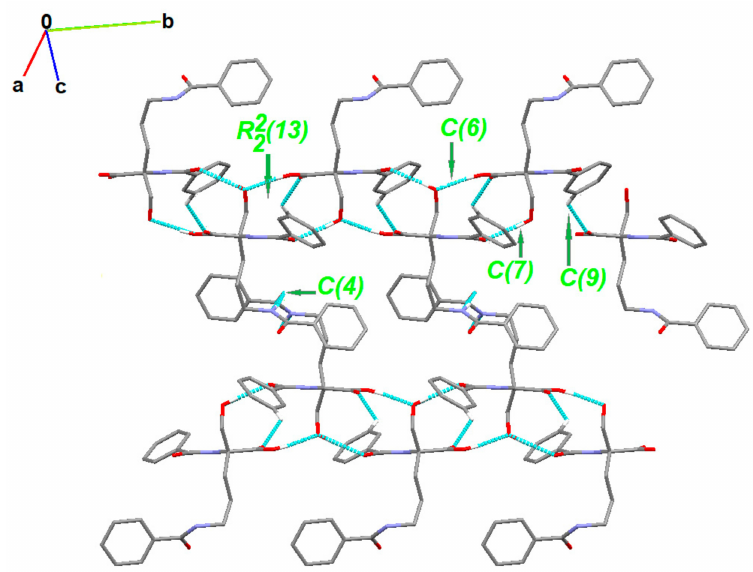
Figure 4. Partial crystal packing of 1 showing supramolecular synthons. H-atoms not involved in the inetractiosn were omitted for